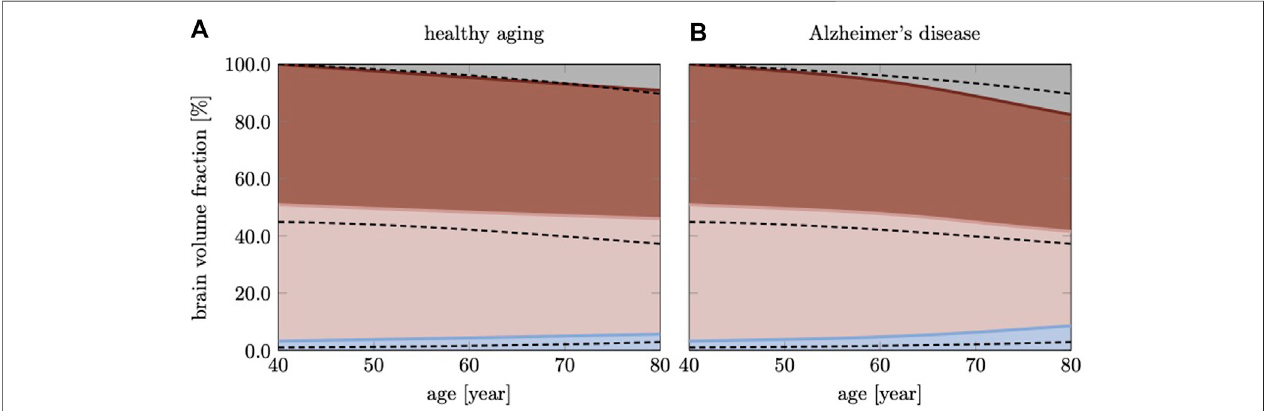
FIGURE7| Cross-sectionalstudies,withsubjectscoveringmanydecadesoflife,provideinsightintothetransientbrainvolumechangesandhowtheybreakdown intothebrain ’ scorticalandsubcorticalregions.Here,wecompareourmodel ’ spredictedgraymatter,whitematter,andventricularvolumefractionwithdatareportedby Coupe etal.(2019)for (A) healthyagingand (B) AD.InAD, weclearly observeadeviationfromhealthyagingintheformofacceleratedatrophy.Thegreyareashowsthe loss of tissue volume that is replaced by fl uid.